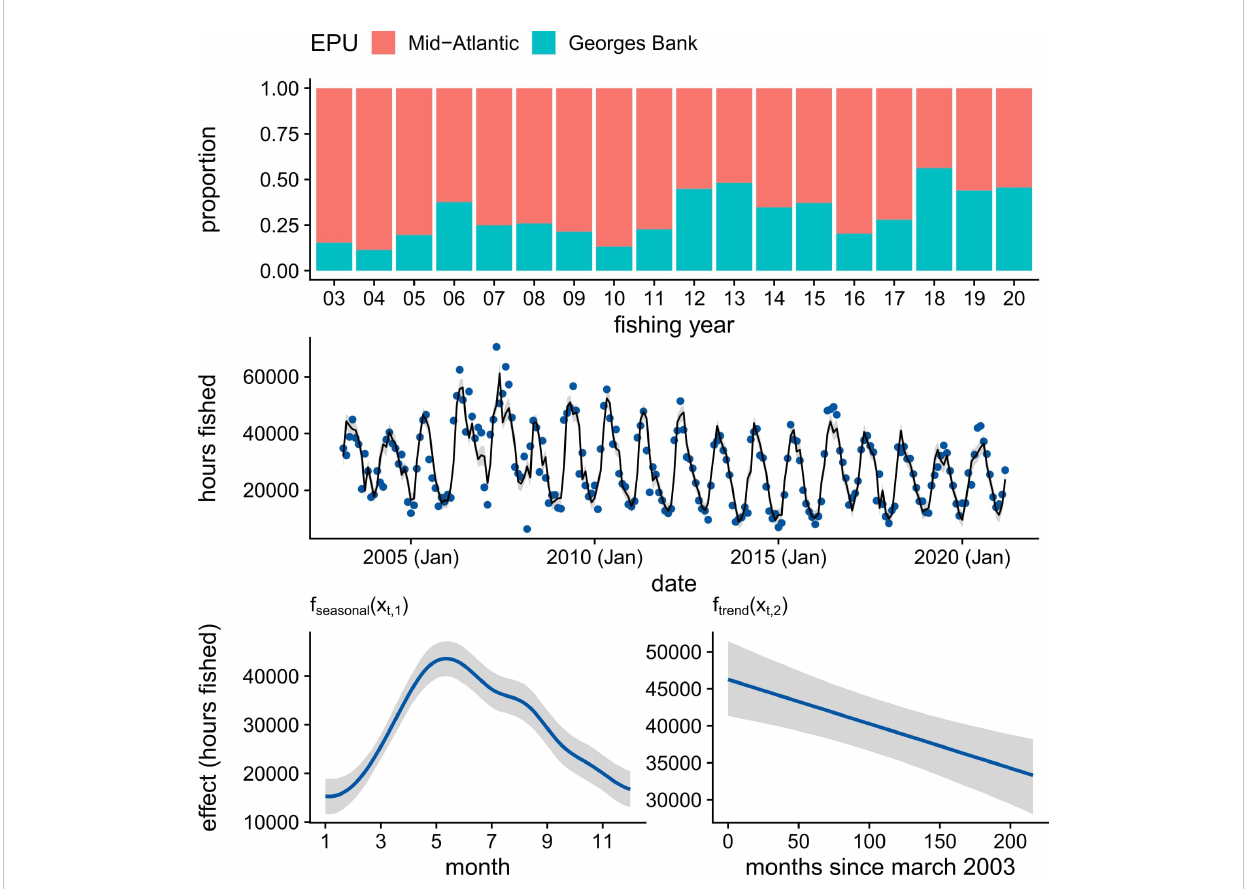
FIGURE 2 Proportion of commercial fi shing effort for the U.S. Atlantic sea scallop fi shery from VMS data for fi shing years 2003 to 2020 found in the Mid- Atlantic and Georges Bank regions (NEFSC, 2021); hours fi shed by date (month, year) for the U.S. Atlantic sea scallop fi shery from VMS data for fi shing years 2003 to 2020 superimposed with fi tted values (line) and 95% credible intervals (shaded region) from the Bayesian generalized additive mixed model (GAMM); smooths (line) for the effects of season and trend on hours fi shed from the Bayesian GAMM, with shaded regions representing 95% credible